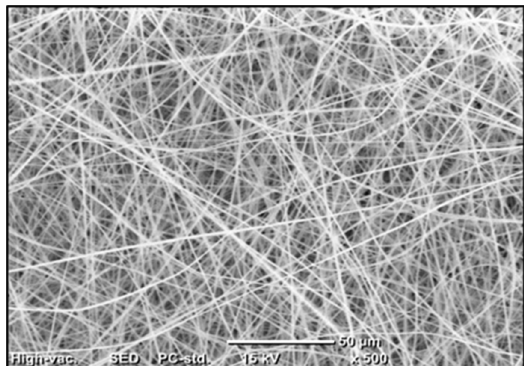
Figure 3. SEM image for PVDF membrane.